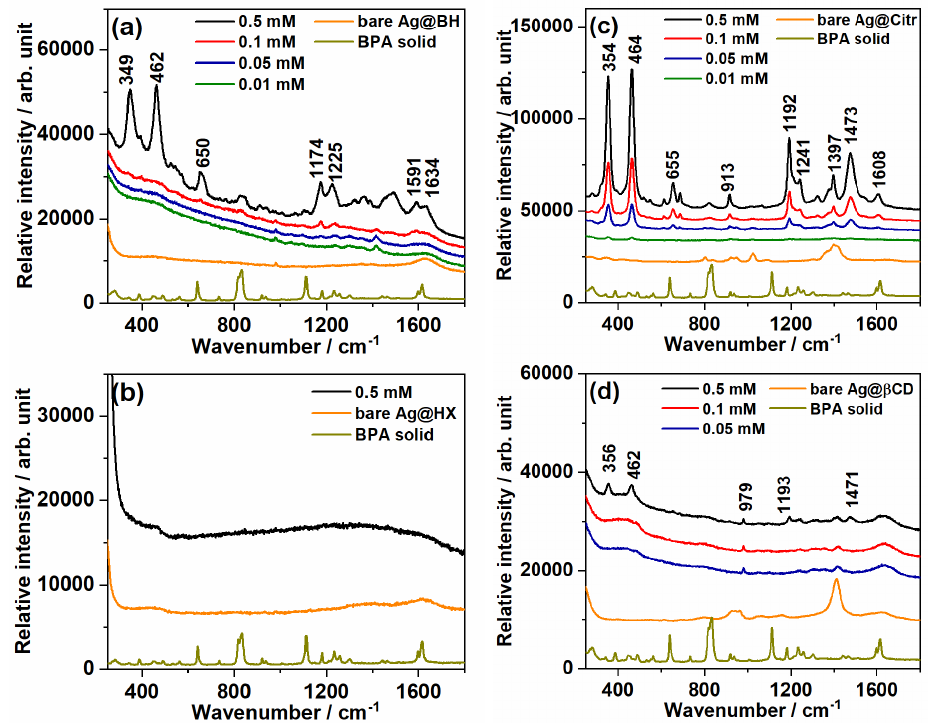
Figure 1. SERS spectra of BPA in a sonicated aqueous solution at different concentration using ( a ) Ag@BH; ( b ) Ag@HX; ( c ) Ag@Citr and ( d ) Ag@βCD NPs. Raman spectrum of solid at the bottom. ( a ) Ag@BH; ( b ) Ag@HX; ( c ) Ag@Citr and ( d ) Ag@ β CD NPs. Raman spectrum of solid at the